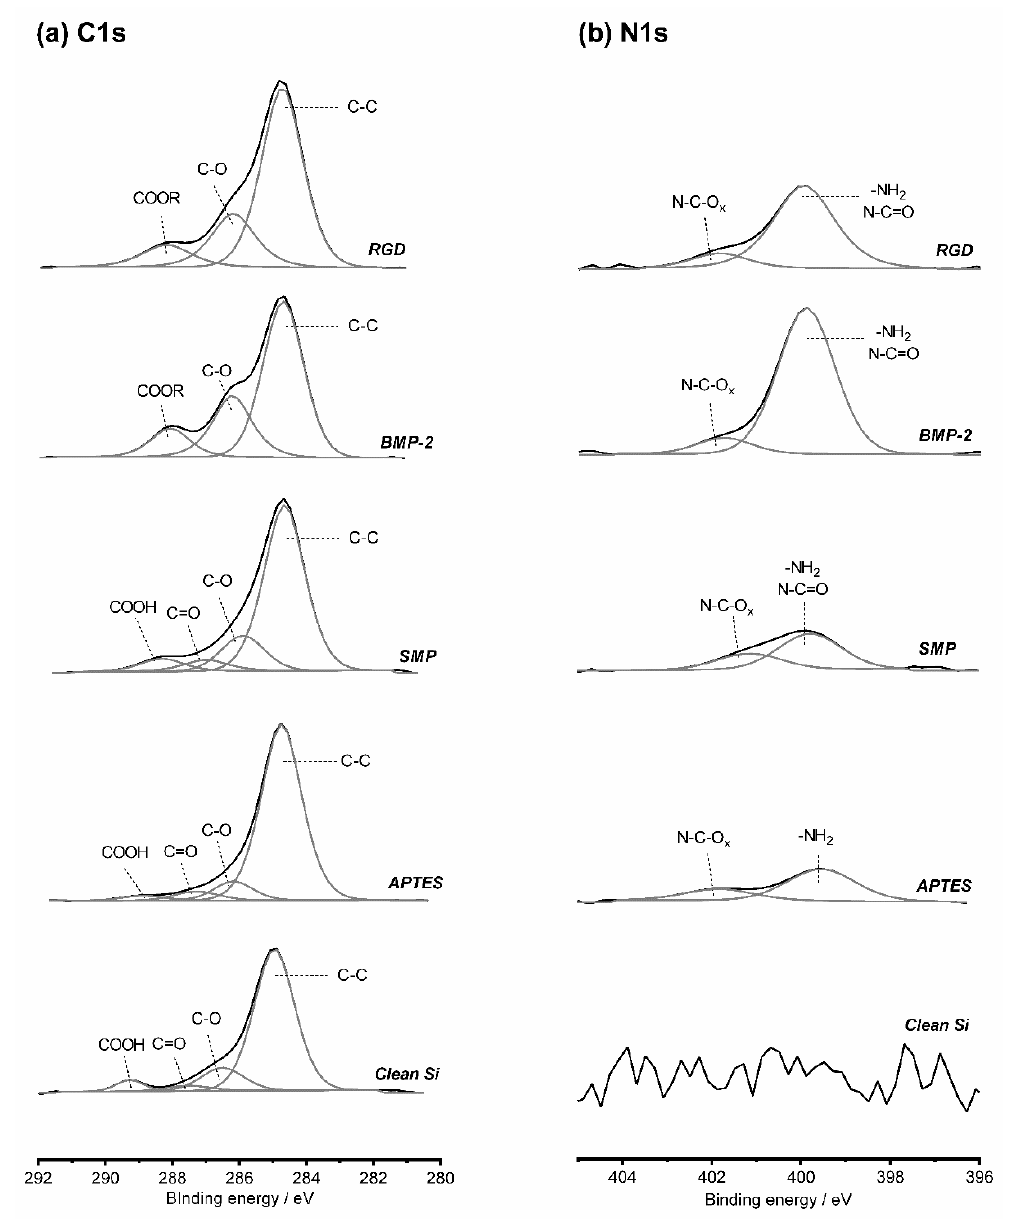
Figure 3. Deconvolution of high resolution XPS spectra of C1s ( a ) and N1s ( b ) at each step of surface functionalization, namely, Si (control), APTES, SMP followed by grafting of RGD or BMP-2 on flat silicon with values as shown in Figure 1 .